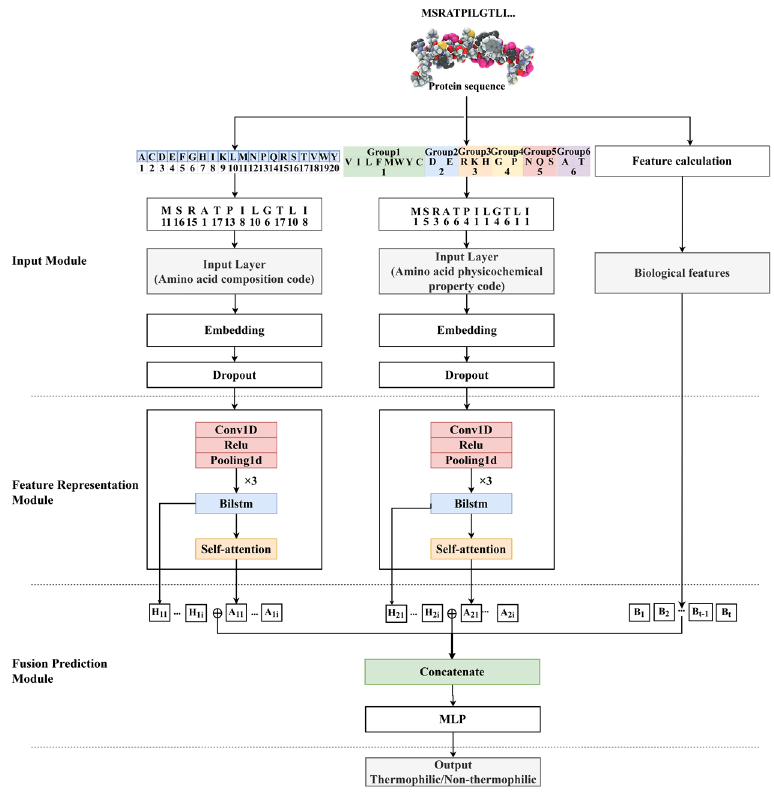
Figure 5. DeepTP